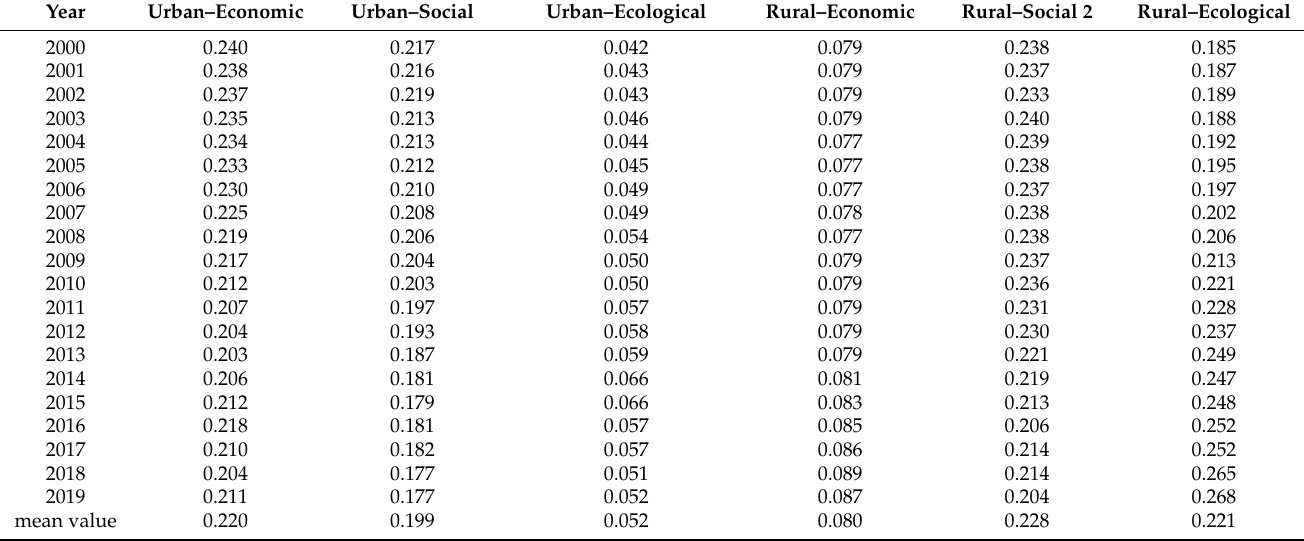
Table 5. Restrictive Degree of Urban–rural Integration Subsystem in Northeast